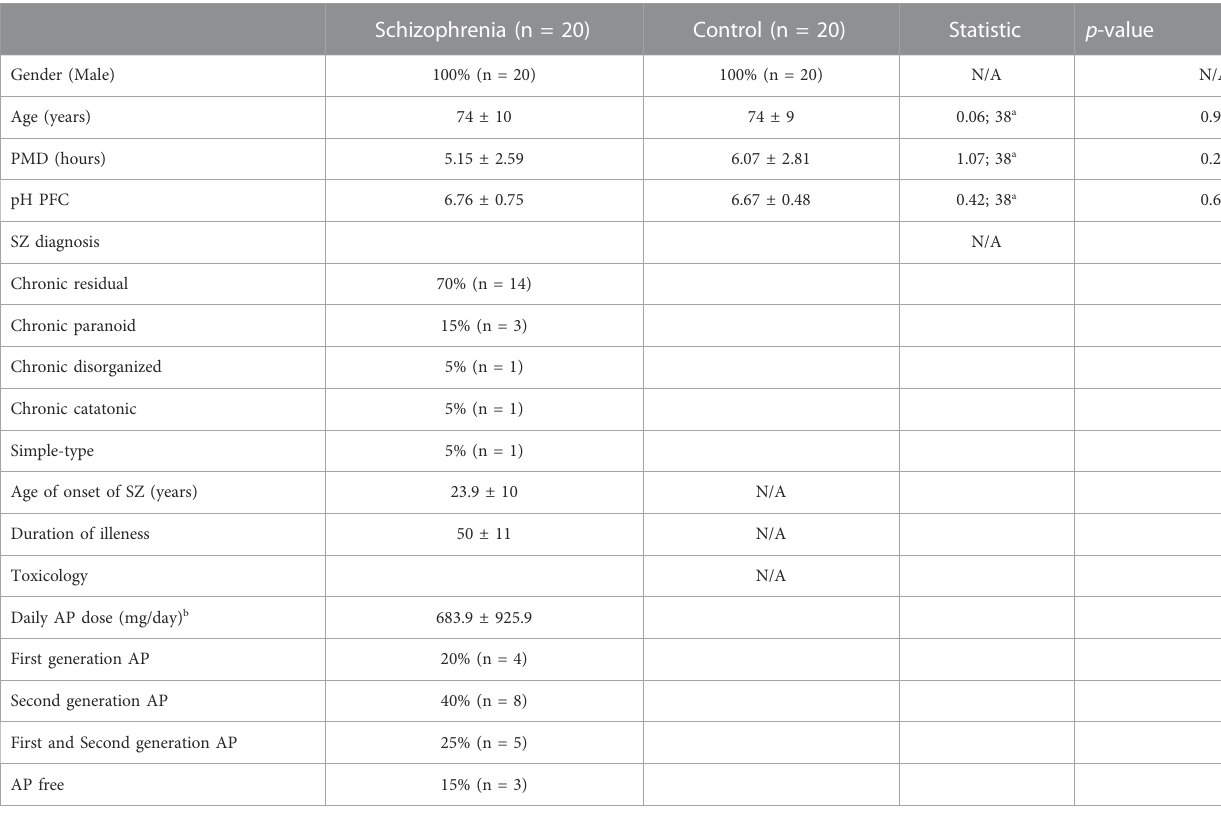
TABLE 1 Demographic, clinical and tissue-related features of